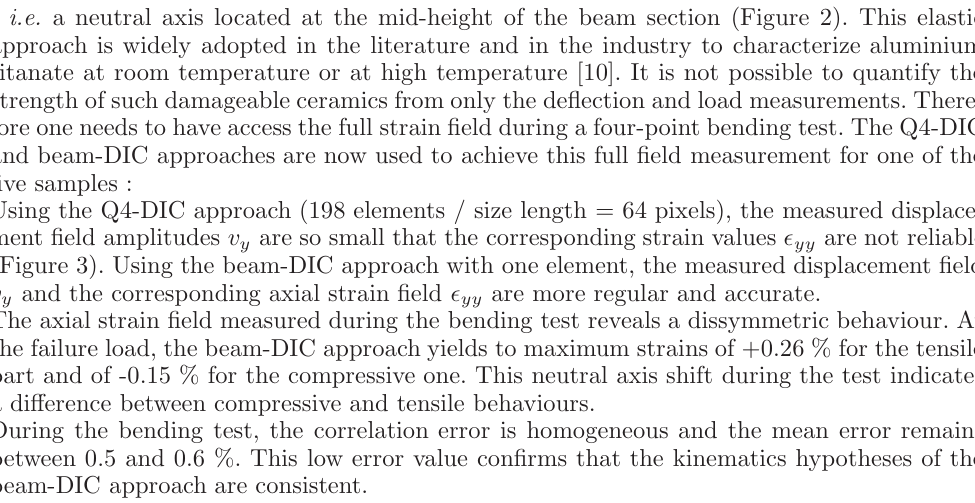
Figure 3. Kinematics measured using the Q4-DIC (left) and beam-DIC (right) approaches just before failure for the bending test - The black line is the iso-0 of (cid:15) yy